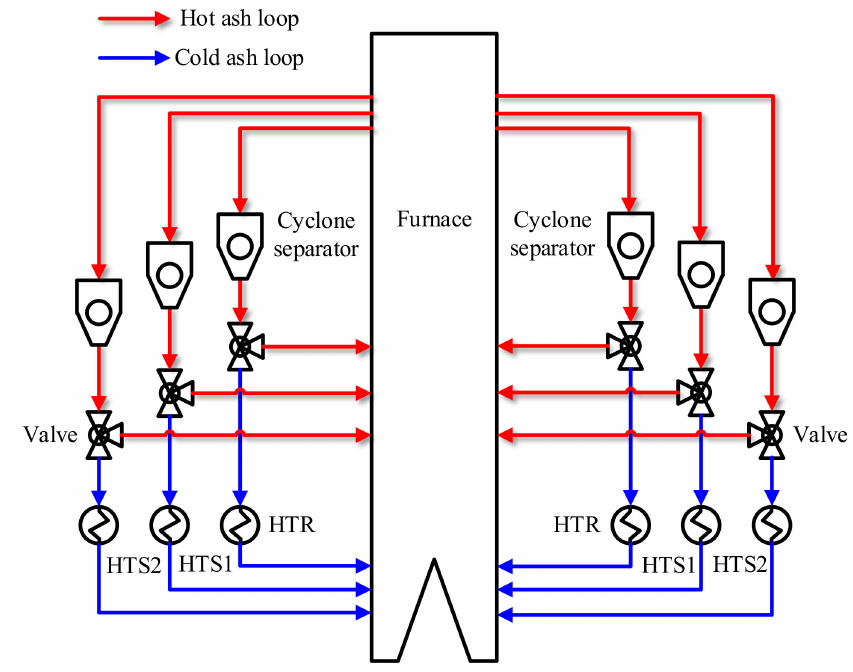
Figure 4. Diagram of the ash circulation